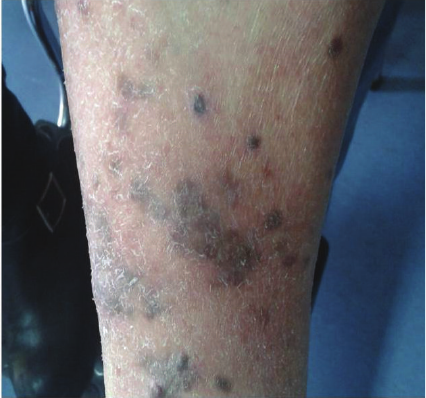
Figure 3: Reddish-violaceous papules, nodules, and infiltrated plaques on the legs.